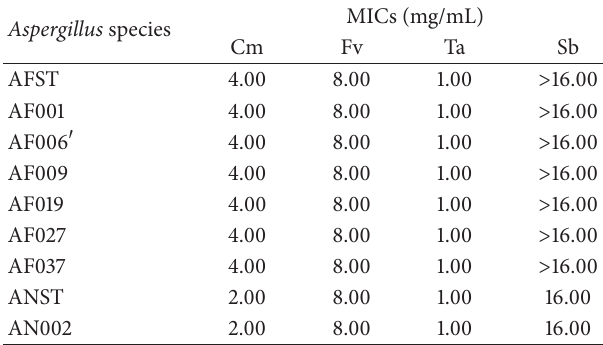
Table 5: Comparative antifungal activity of essential oils with sodium